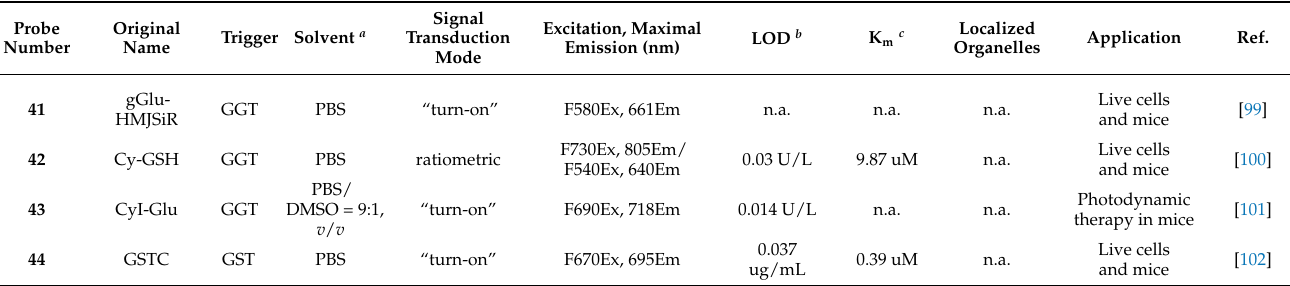
Table 3. Properties of NIR fluorescent Probes 41 − 44 .